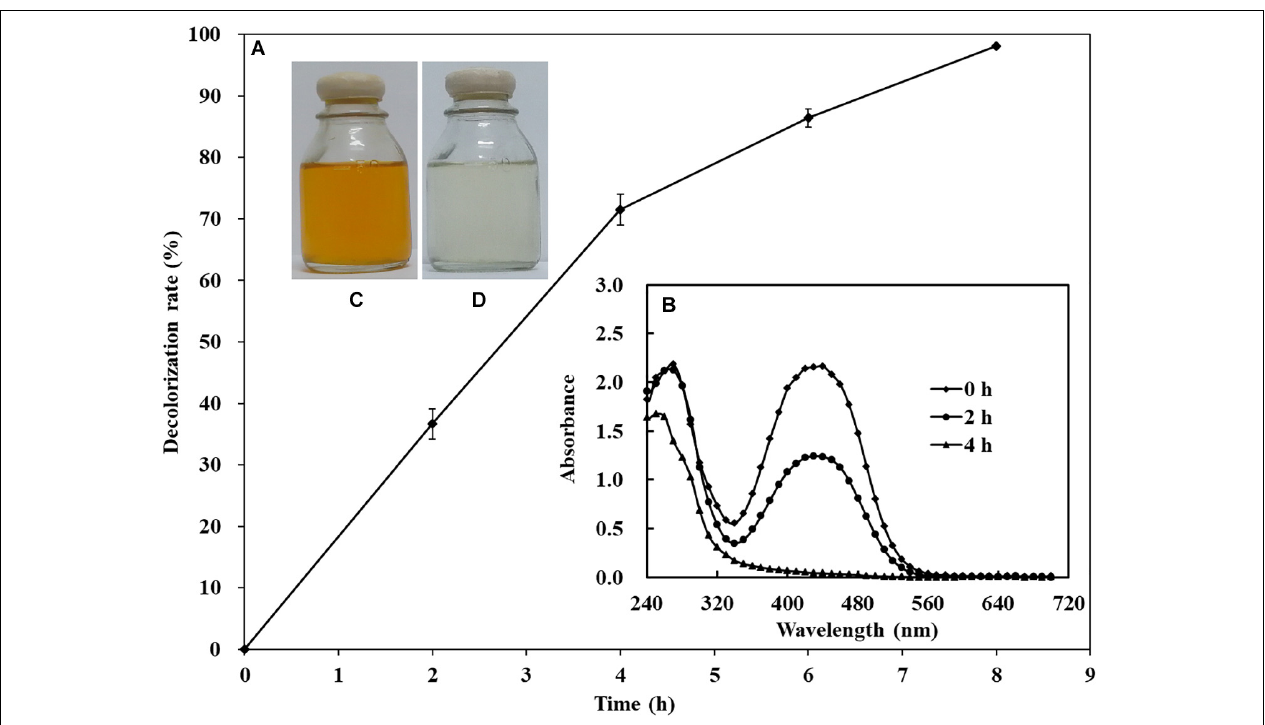
FIGURE 2 | Decolorization of 200 mg/L of AY by S. putrefaciens CN32 (A) . Scanning spectrum analysis of 50 mg/L of AY decolorized by S. putrefaciens CN32 at different time intervals (B) . The image of 50 mg/L AY before (C) and after (D)